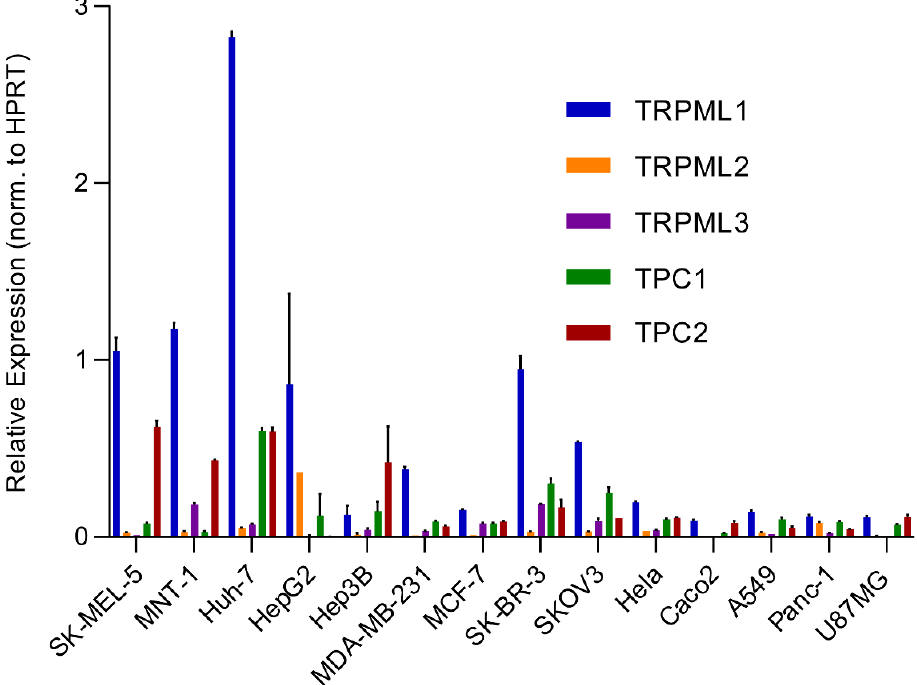
Figure 2. Gene expression profile of endolysosomal cation channels in different cancer cell lines. The expression levels of endolysosomal cation channels TRPML1, TRPML2, TRPML3, TPC1 and TPC2 were assessed in different cancer cell lines using real-time quantitative Reverse Transcription PCR (qRT-PCR): melanoma (SK-MEL-5 and MNT-1); hepatocellular carcinoma (HUH-7, HebG2, and Hep3B); breast cancer (MDA-MB-231, MCF-7 and SK-BR-3); colon adenocarcinoma (Caco-2); ovarian cancer (SKOV-3), cervical adenocarcinoma (Hela); pancreatic ductal adenocarci- noma (Panc-1); glioblastoma (U87MG); lung adenocarcinoma (A-549). Melanoma and HCC lines